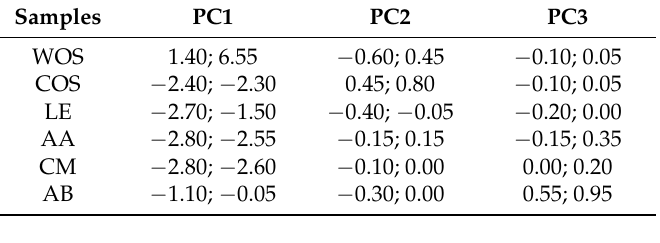
Figure 5. Three-dimensional PCA score plot for discriminating six sample groups. The first three principal components are displayed, accounting for 99.01%, 0.63%, and 0.34% (99.98% in total) of the total variation, respectively. Table 2. The ranges of sample values in the three-dimensional scatter plot (PC1 vs. PC2 vs. PC3).